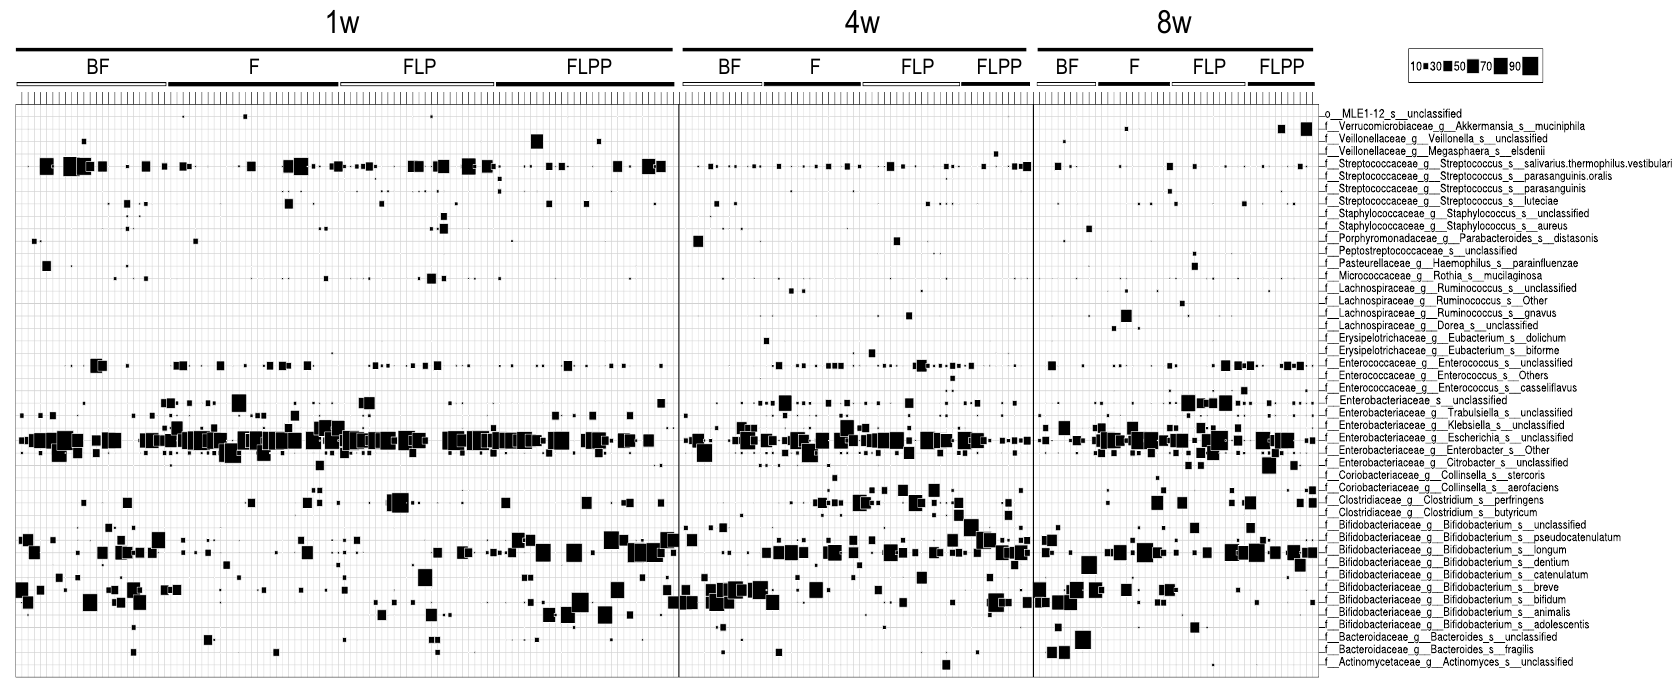
Figure 3. Gut microbiota composition in infants from the four nutritional intervention groups (PP data set). Determination by 16S rRNA gene sequence analysis: bubble plot of bacteria determined at species level (identified at the right ordinate) for the intervention groups and time points specified on the top abscissa. The proportion of the specified bacterium in the specified sample is indicated by the size of the square (key at top right of the